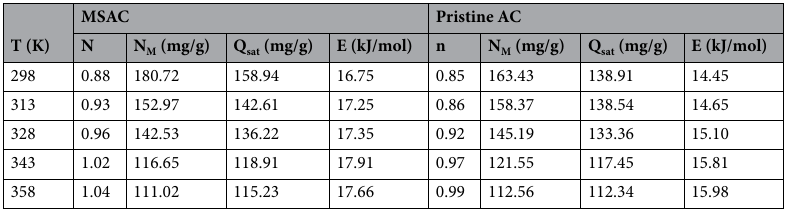
Table 4. Statistical physics parameters for the phenol adsorption on MSAC and pristine activated carbon based on the single-layer